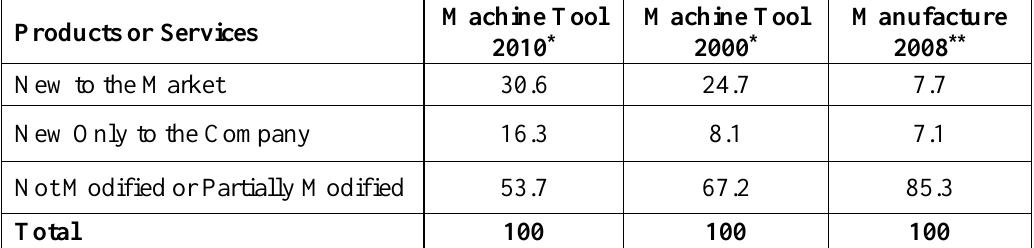
Table 2: Revenues Share of the Different Categories of Product Innovation in the Last Three Years (% of the Total Turnover of Enterprises) Products or Services